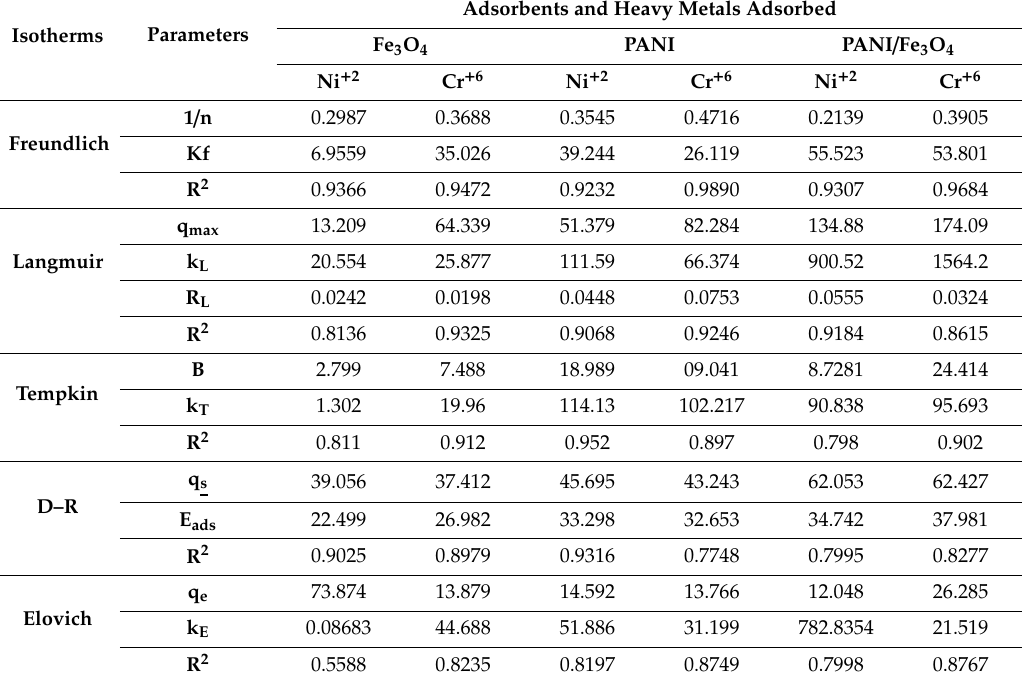
Table 1. Isotherm parameters calculated for Cr(VI) and Ni(II) adsorbed on Fe 3 O 4 , PANI, and Fe 3 O 4 / PANI